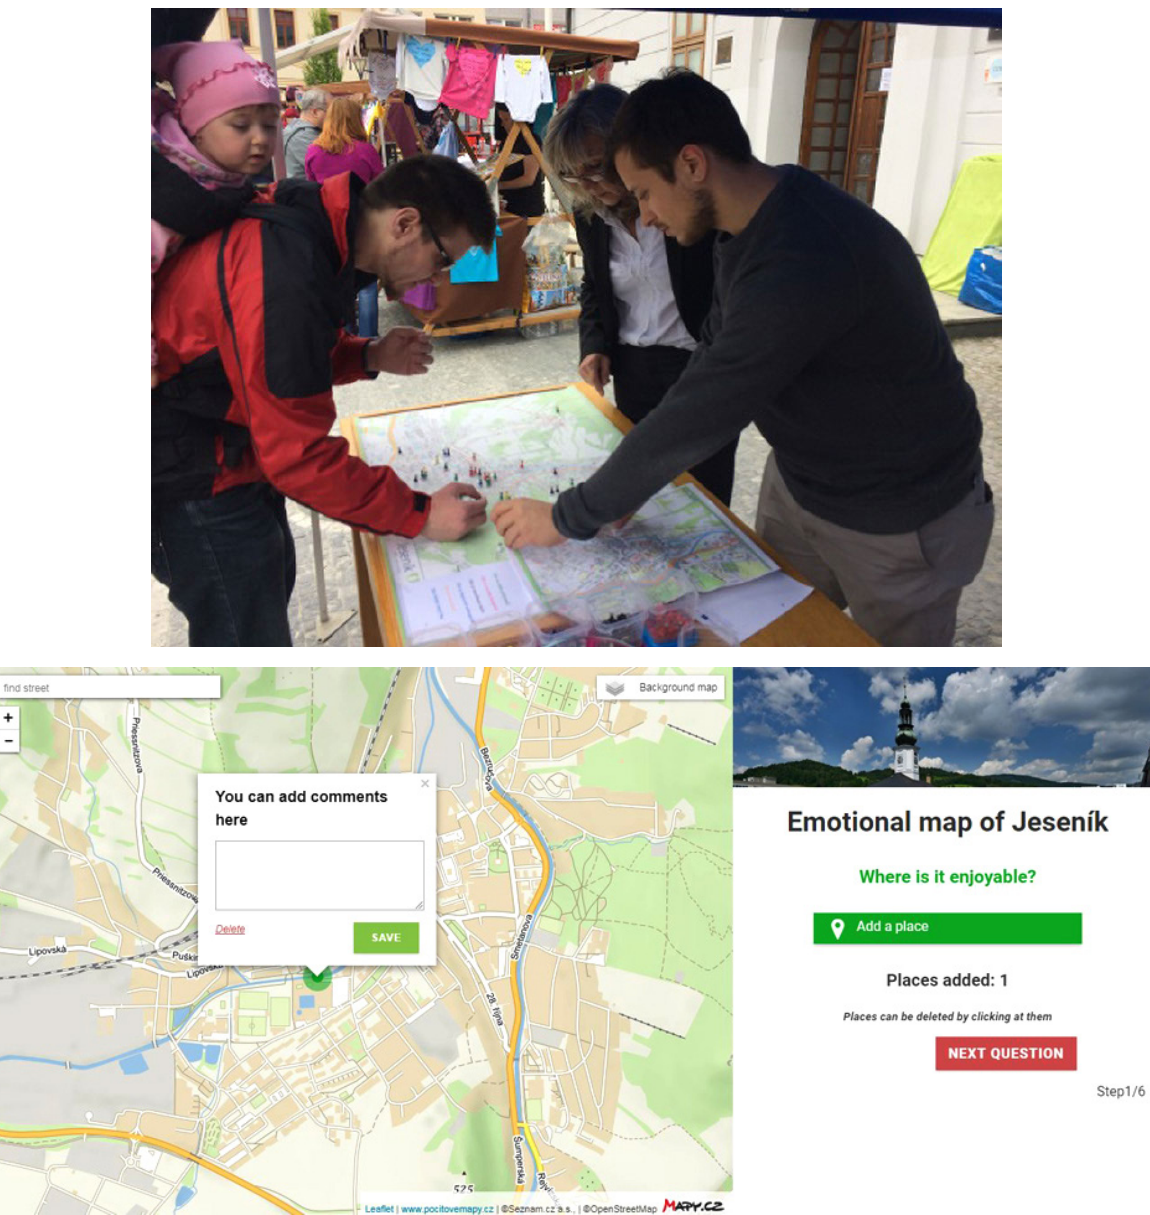
Fig. 1. Analogue mapping during the festival (up) and printscreen of the web-mapping platform